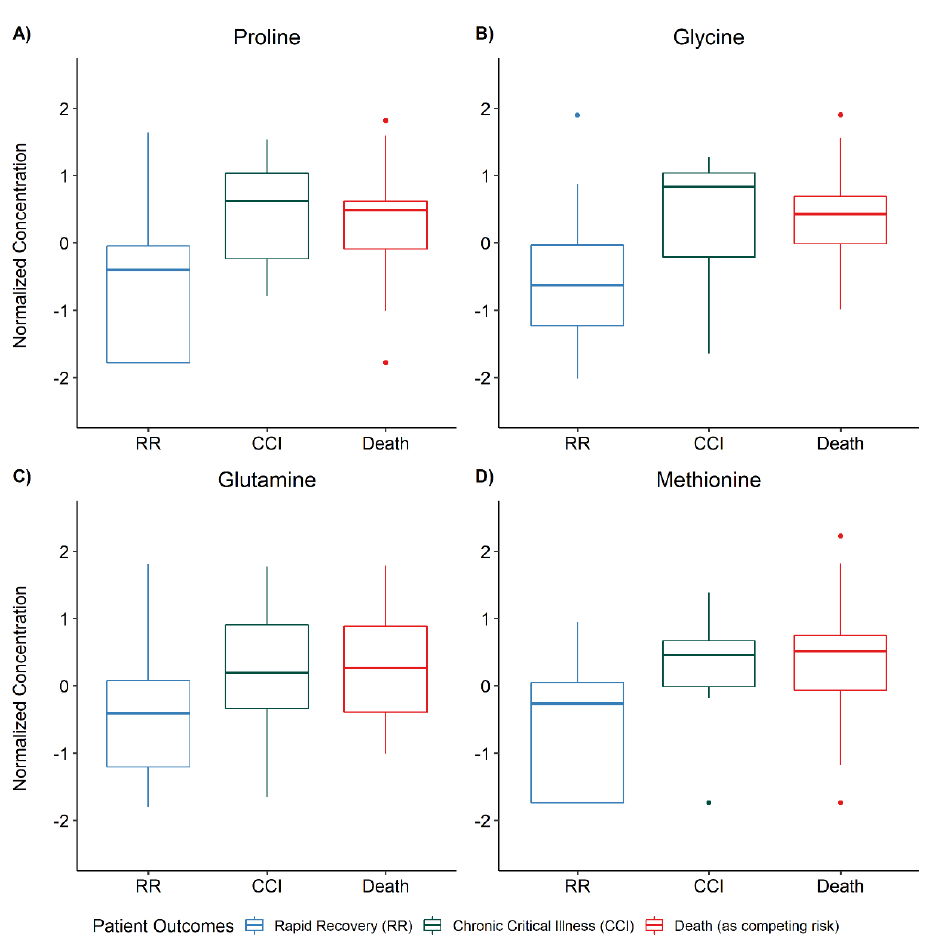
Figure 4. Serum amino acid concentration differences between chronic critical illness (CCI) and rapid recovery (RR) patients. One-way analysis of variance (ANOVA) was used to determine differences in metabolite concentrations stratified by patient outcomes. The ANOVA p -values were corrected for multiple comparisons according to the false discovery rate (FDR) procedure of Benja- mini–Hochberg and post-hoc testing for between-group differences was done according to Fisher’s Least Square Difference when the FDR was less than 0.05. Four metabolites (proline, glycine, gluta- mine, and methionine) were different (FDR < 0.05) between patients who developed CCI and those who experienced a RR.